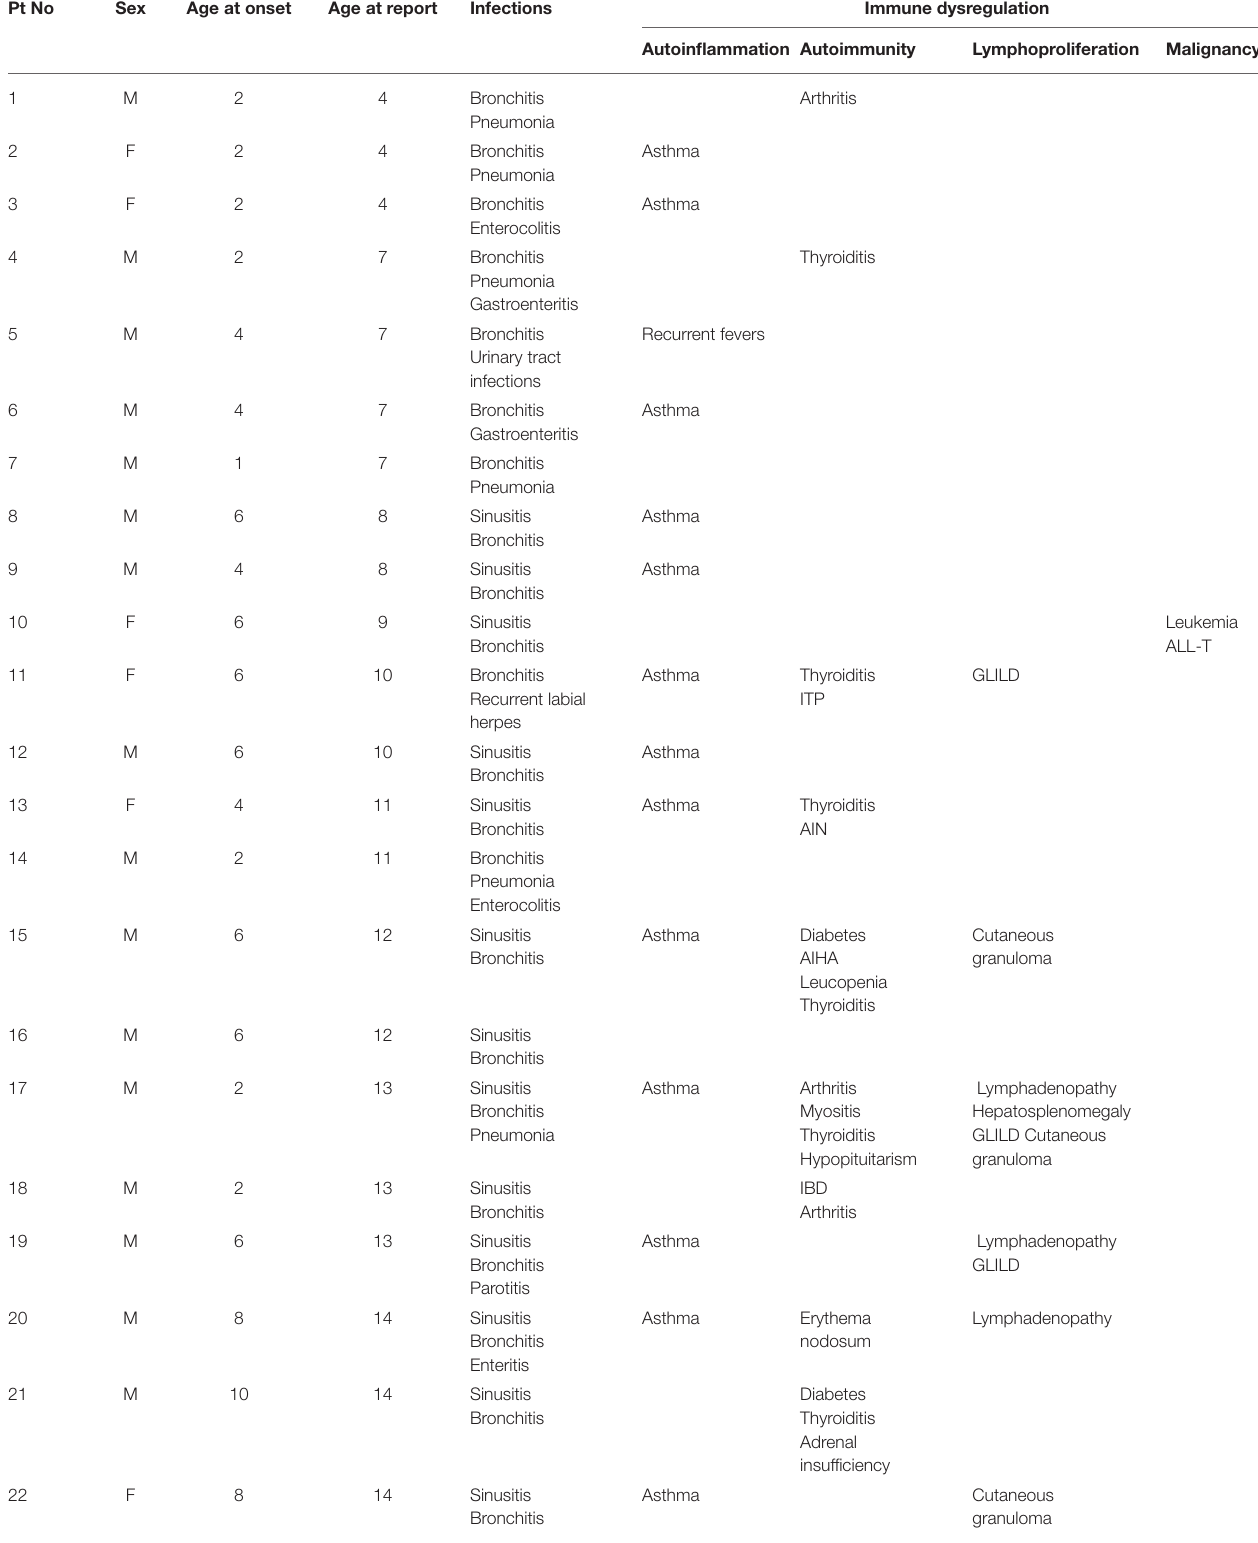
TABLE 1 | Infectious and non-infectious complications in patients with pediatric